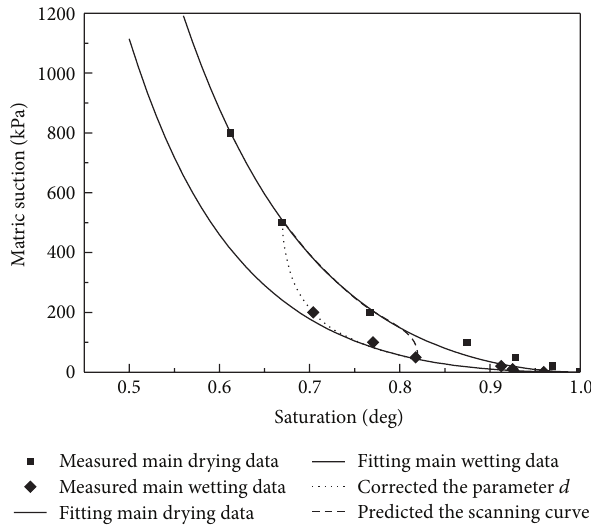
Figure 8: The fitting tested curve of SWRC for sand-kaolin mixture (measured data from Goh et al. [5]).